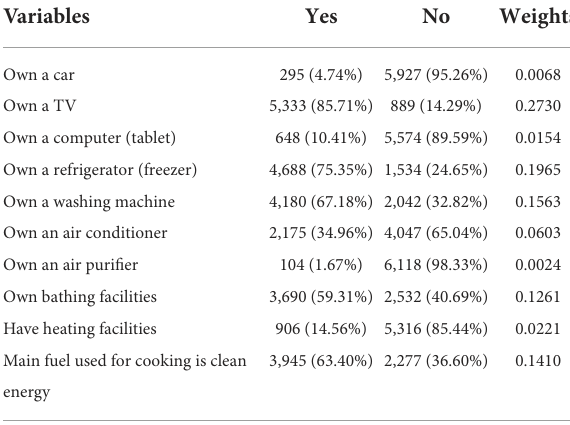
TABLE 1 Data statistics and weights for each dimension of energy